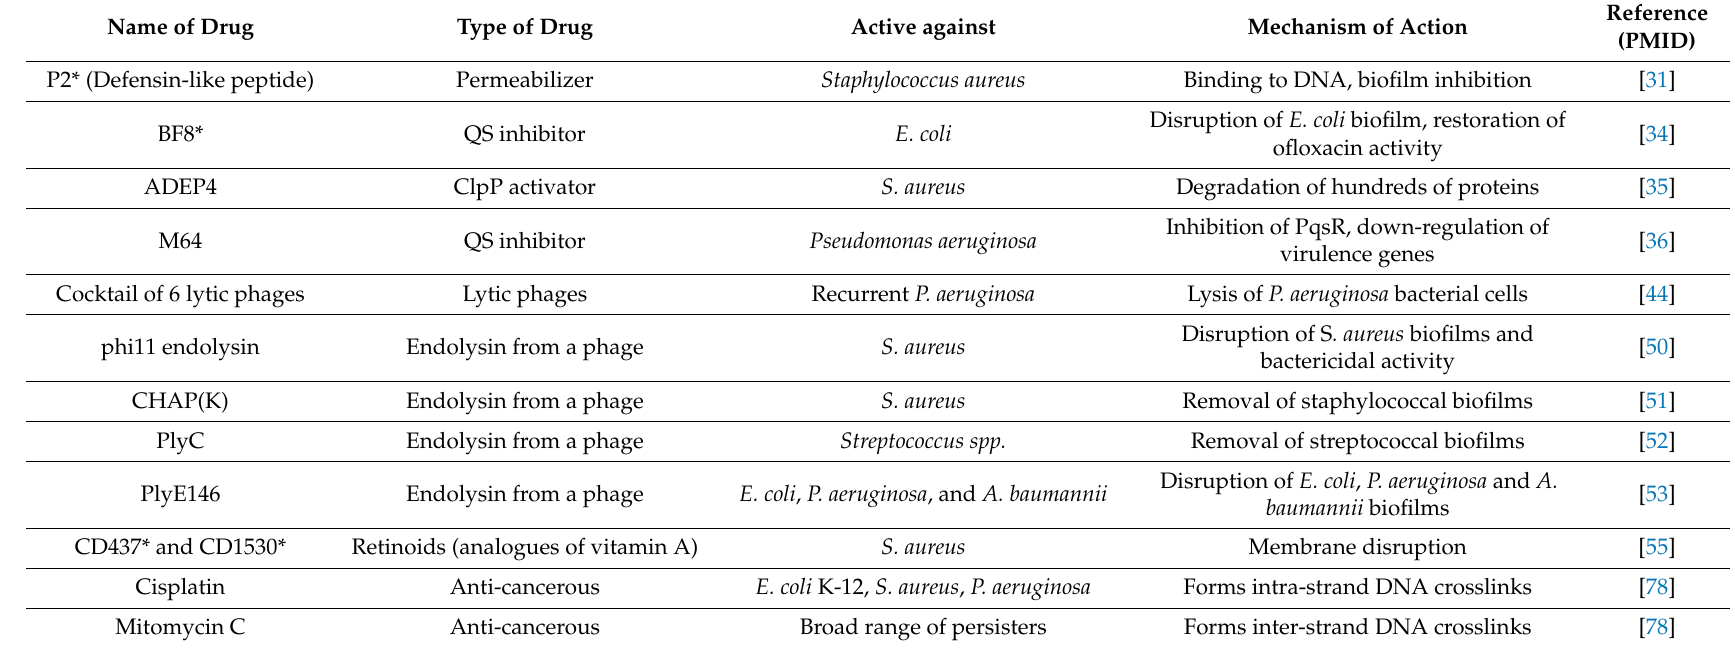
Table 2. Anti-persister molecules that show results against persistent